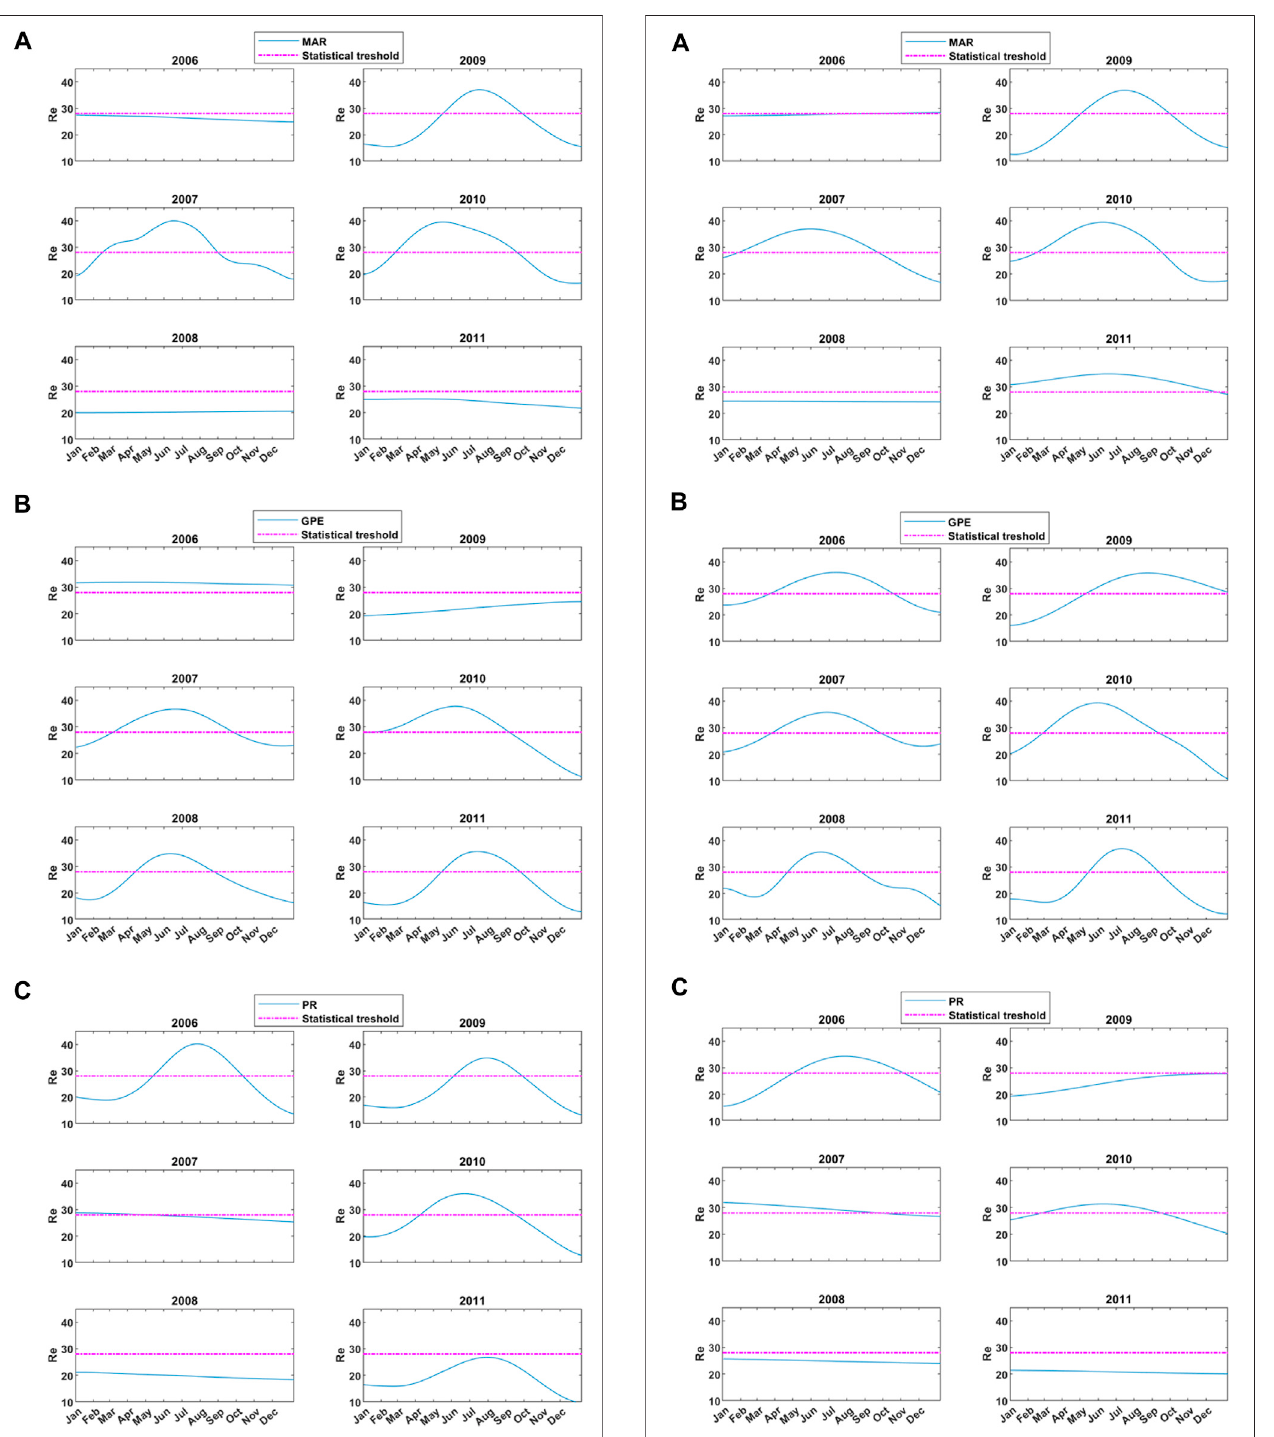
FIGURE 9 | Residual (Re) from CEEMDAN for (A) Martinique (MAR), (B) Guadeloupe (GPE) and (C) Puerto-Rico (PR) by year. The horizontal purple dash-dot line represents the PM 10 statistical threshold estimated over 11 years at 28 μ g/m 3 .